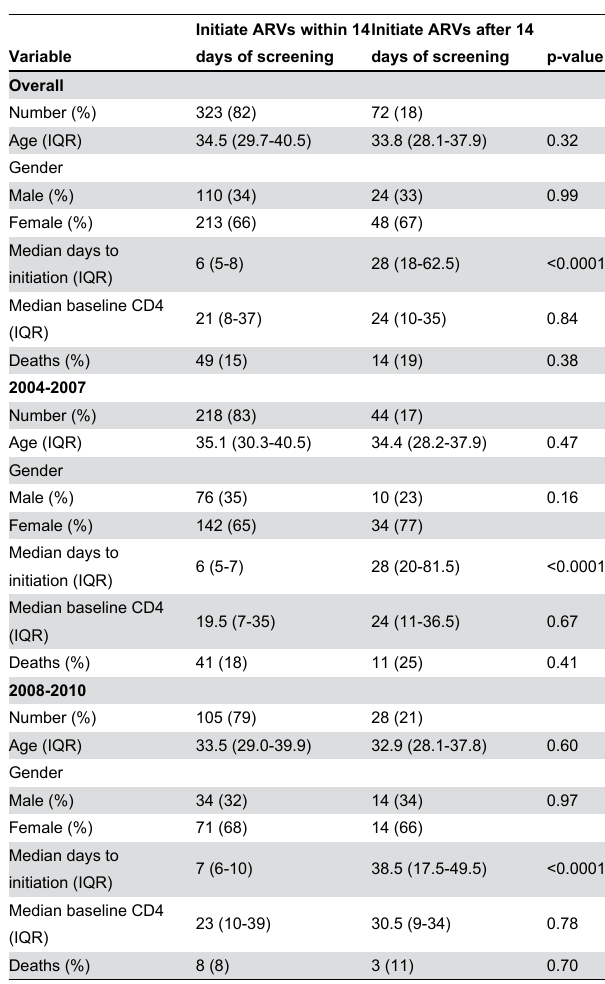
Table 1. Patient characteristics at enrolment into the treatment access program.